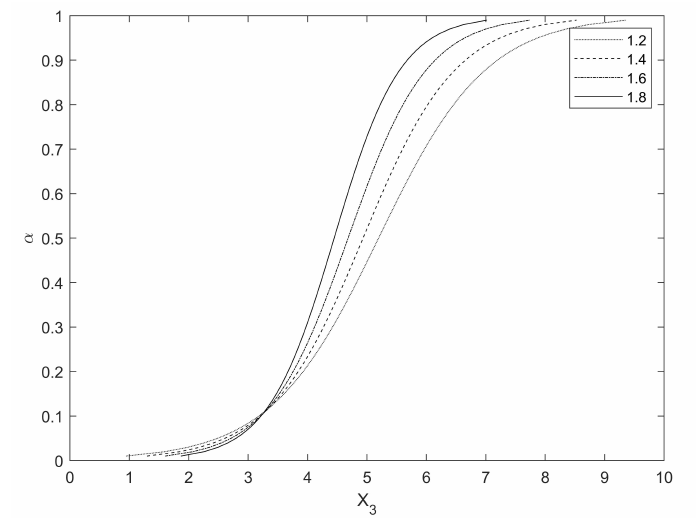
Figure 4. The uncertainty distribution of X 3 with different orders p .